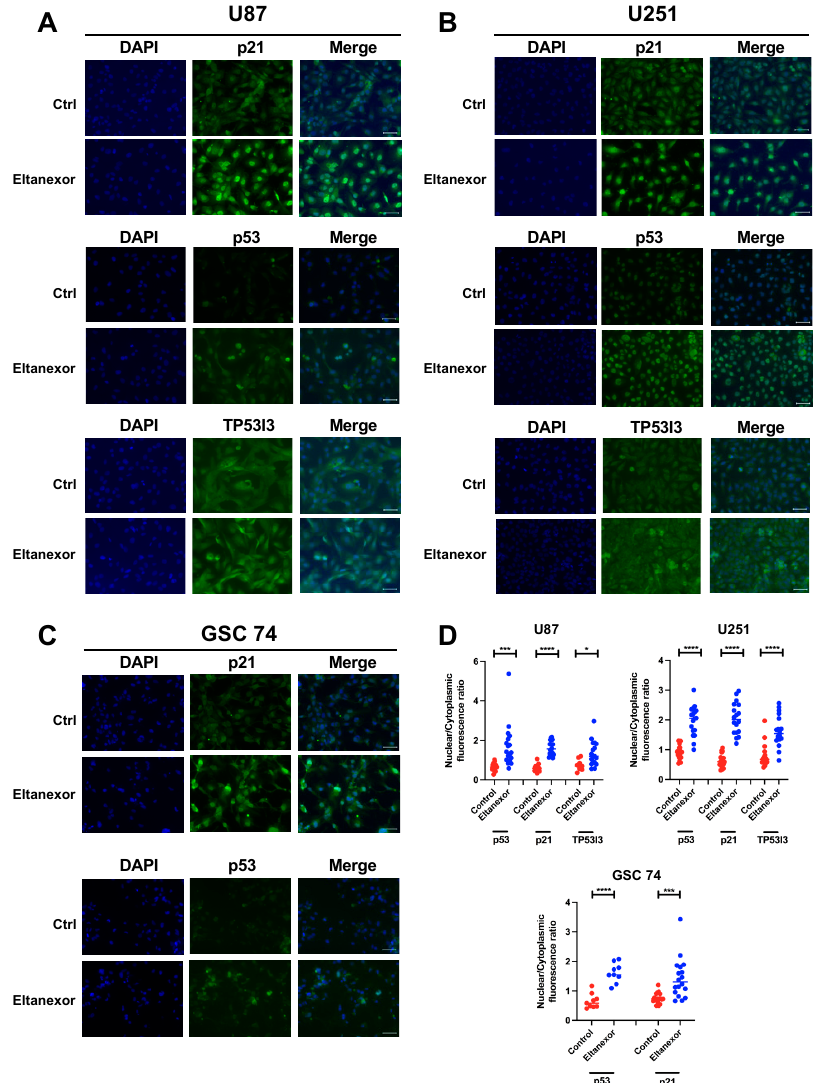
Figure 4. Immunofluorescence of U87 ( A ) and U251 ( B ) cells for CDKN1A, p53, and Tp53i3 and of GSC 74 cells ( C ) for CDKN1A and p53 after treatment with Eltanexor (100 nM) or the corresponding volume of vehicle (DMSO, “Ctrl”) for 24 h. Staining with either DAPI, antibodies, or merged images. Overlay of nuclear signals with DAPI is visible in Eltanexor treated cells. Scale bar, 50 µm, valid for all images. ( D ), quantification of the nuclear to cytoplasmic ratio for fluorescence signals detected as revealed by counting at least 9 individual cells ( n dots). All ratios >1 denote nuclear accumulation. Significances were determined by Student’s t -test with *, p < 0.05, ***, p < 0.001, and ****, p < 0.0001.